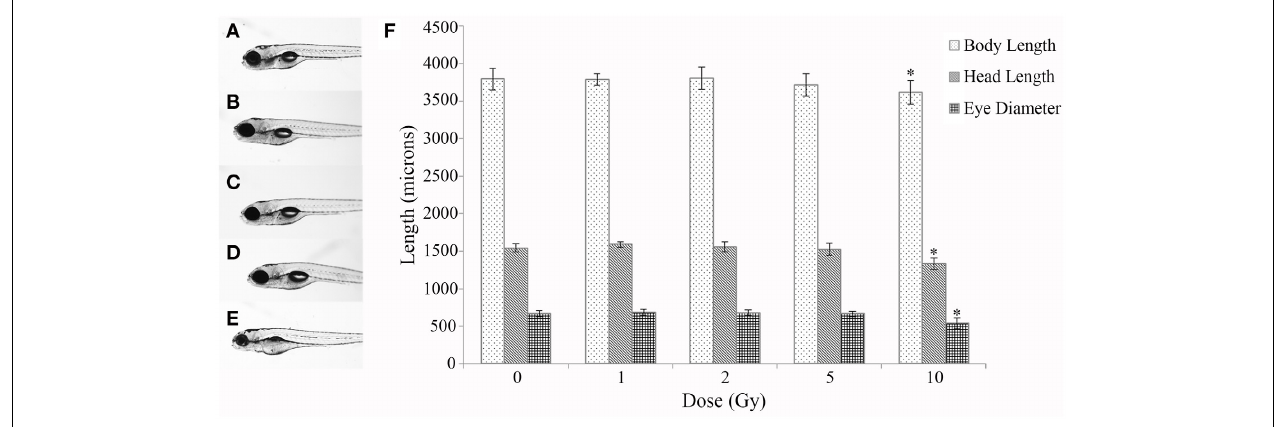
treatments. A significant decrease in body length, head length, and eye diameter was seen only in the 10 Gy treatment compared to the control treatment (F) . ( n = 10–12; ∗ p < 0 . 05; error bars depict standard deviation).